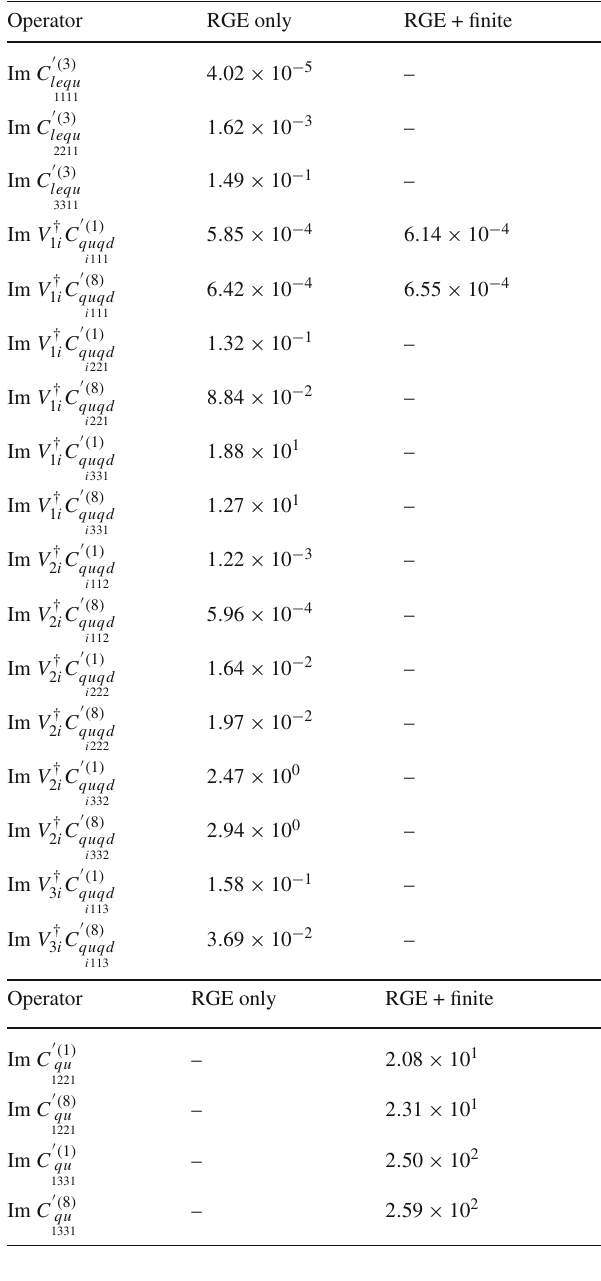
( 1 , 8 ) , qd (cid:4) ( 1 , 8 ) C 1 i